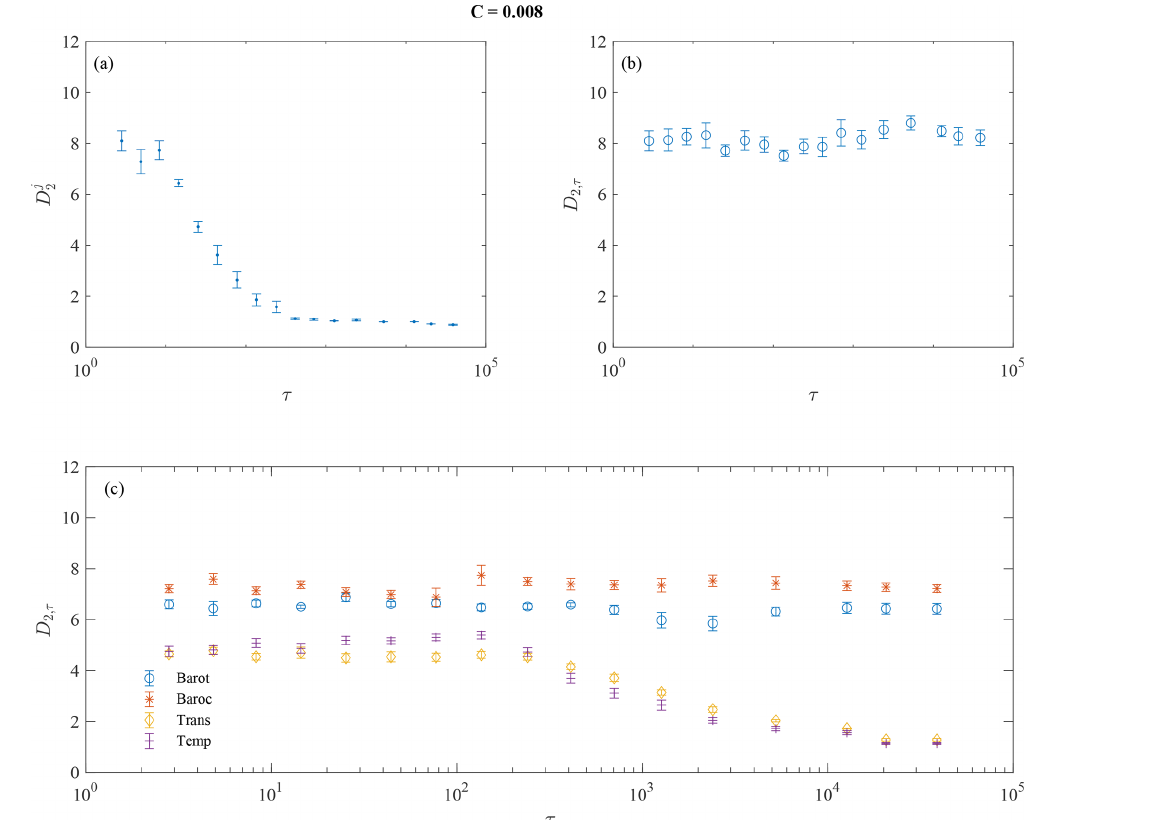
Figure 5. Multiscale correlation dimension D 2 ,τ for C = 0 . 008 at different timescales τ j for different cases: (a) for each MIMF individually ( D j ), (b) for reconstructions of MIMFs as in Eq. (12) ( D 2 ,τ ), and (c) for reconstructions of MIMFs separately for each variable (barotropic 2 modes – blue circles, baroclinic modes – orange asterisks, transport modes – yellow diamonds, and temperature modes – violet symbol). Each panel also shows the 95% confidence intervals as error